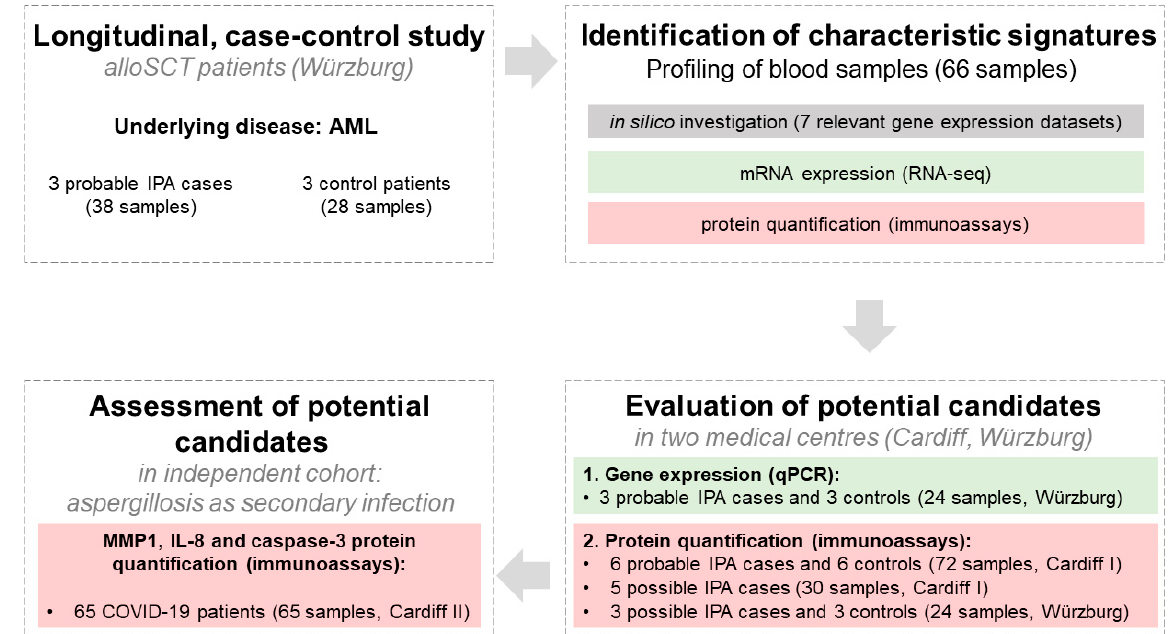
Figure 1. Workflow of a longitudinal case-control study investigating characteristic signatures indi- cating IPA among alloSCT patients. Characteristic signatures were identified by in silico investigation along with transcriptome and protein profiling of selected probable IPA cases and controls (Würzburg cohort). Potential molecular candidates were evaluated in additional alloSCT patients (Cardiff I, Würzburg) categorized as probable and possible IPA cases. The specificity of selected molecular candidates was investigated in independent cohorts consisting of CAPA patients and COVID-19 control patients (Cardiff II).